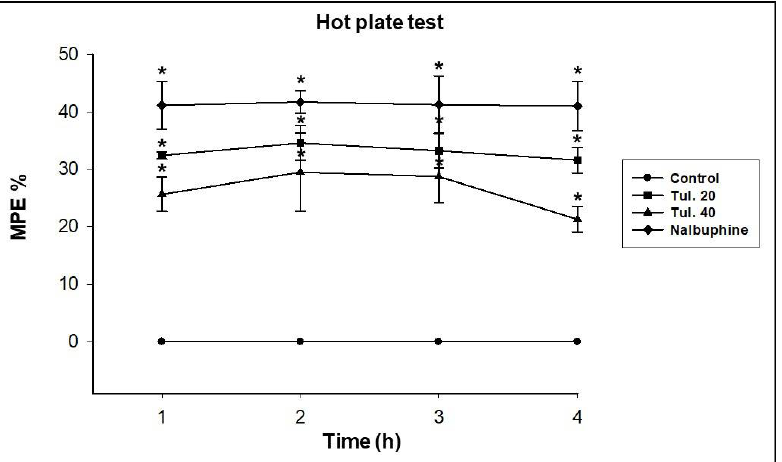
Figure 2. The percentage of maximal possible effect (MPE%) of nalbuphine hydrochloride (2.2 mg/kg BW s.c.) and tulathromycin at 20 (Tul. 20) and 40 (Tul. 40) mg/kg BW s.c. in mice using the hot-plate test. Data are expressed in mean ± SD; n = 5. * Significantly different from control, p < 0.05. Table 2. Effects of tulathromycin (20 and 40 mg/kg BW, s.c.) and nalbuphine hydrochloride (2.2 mg/kg BW, s.c.) on the latency of nociceptive response induced in the tail-flick test in mice (mean ± SD; n = 5). Dose, s.c. Group Two (mg/kg BW)